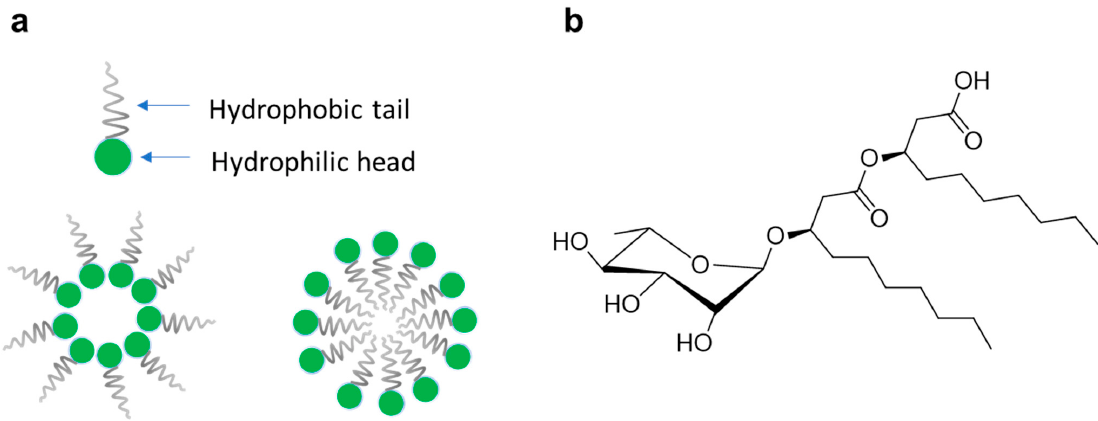
Figure 1. Biosurfactant overview ( a ); and mono-RL general structure ( b